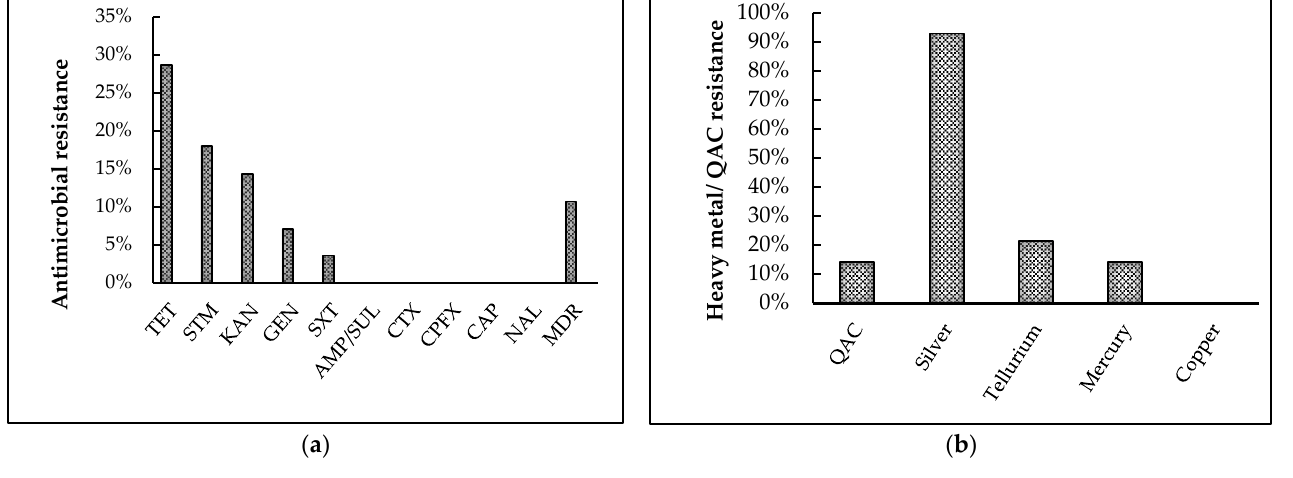
Figure 5. Results of phenotypic antimicrobial and heavy-metal resistance pattern of broiler breeder APEC isolates. ( a ) Antibiotic-resistance patterns towards ten antibiotics were tested using Kirby– Bauer disk diffusion assay. TET: tetracycline, STM: streptomycin, KAN: kanamycin, GEN: gentamicin, SXT: sulphamethoxazole-trimethoprim, AMP/SUL: ampicillin/ sulbactam, CTX: cefotaxime, CPFX: ciprofloxacin, CAP: chloramphenicol, NAL: nalidixic acid, MDR: multi- drug resistance ( b )